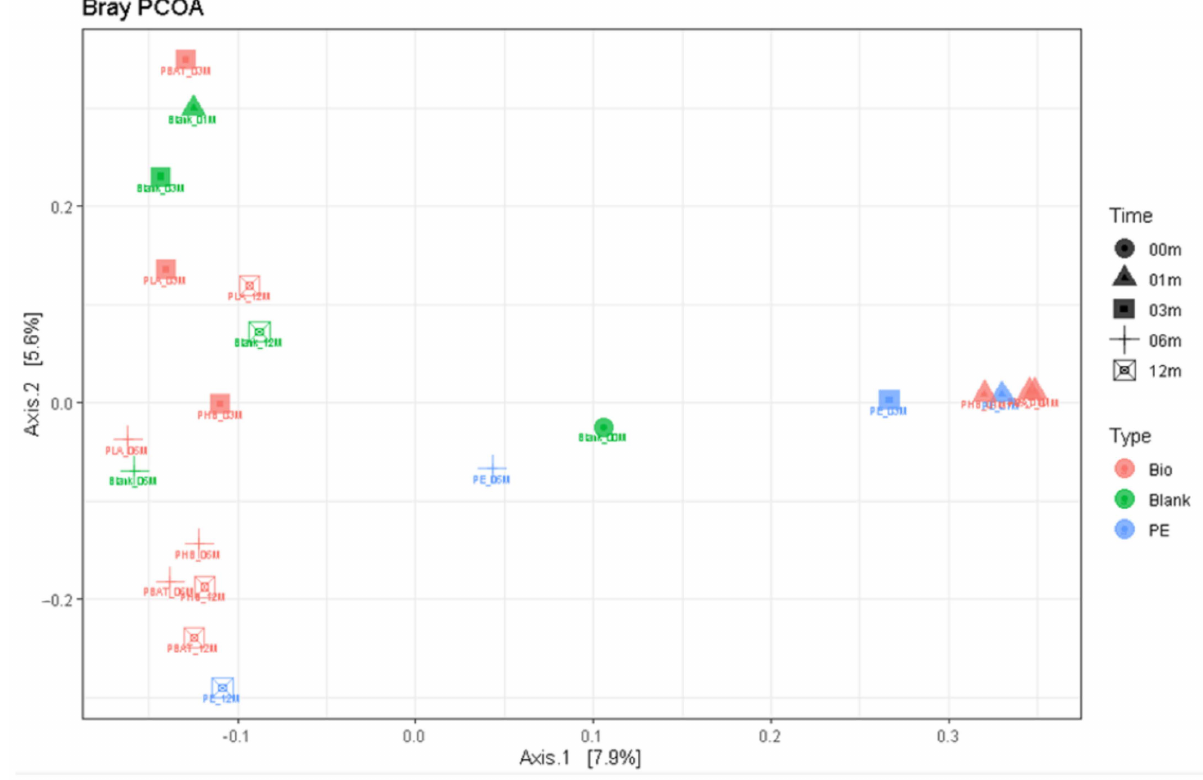
Figure 10. Principal component analysis scatter plot based on 16S rDNA of